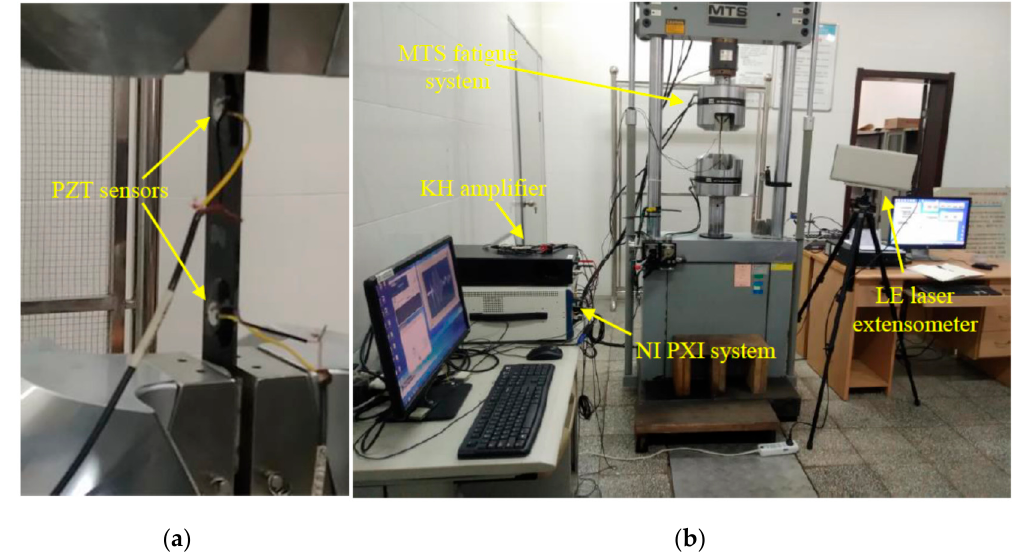
Figure 1. Experimental setup: ( a ) glass fiber/epoxy GF/EP specimen and ( b ) fatigue test and monitoring systems.